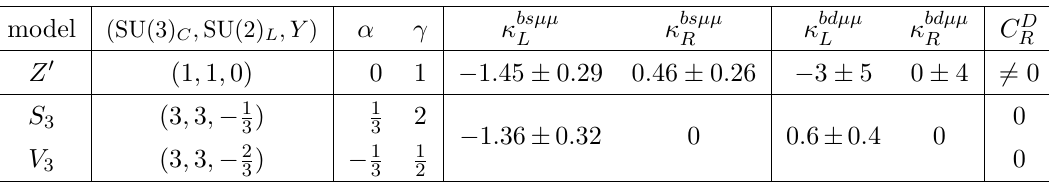
Table 4 . Values for α and γ (5.8) for different BSM tree-level mediators [61]. In the second column the representation of the corresponding mediator under the SM gauge group is shown. The values of κ bsµµ within 1 σ uncertainties are from b → s µ + µ − global fit results, see appendix D L ( R ) for details, whereas the κ bdµµ values are provided by a fit of b → d µ + µ − observables, see main L ( R ) text and ref. [54] for details. The last column displays which dineutrino Wilson coefficient is not generated by the